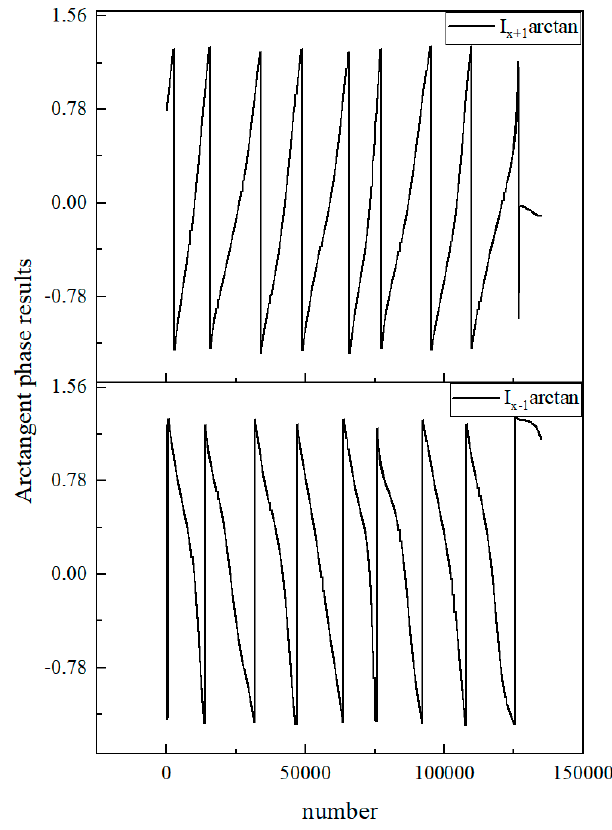
Figure 7. Positive level’s and negative level’s arctangent phase results.